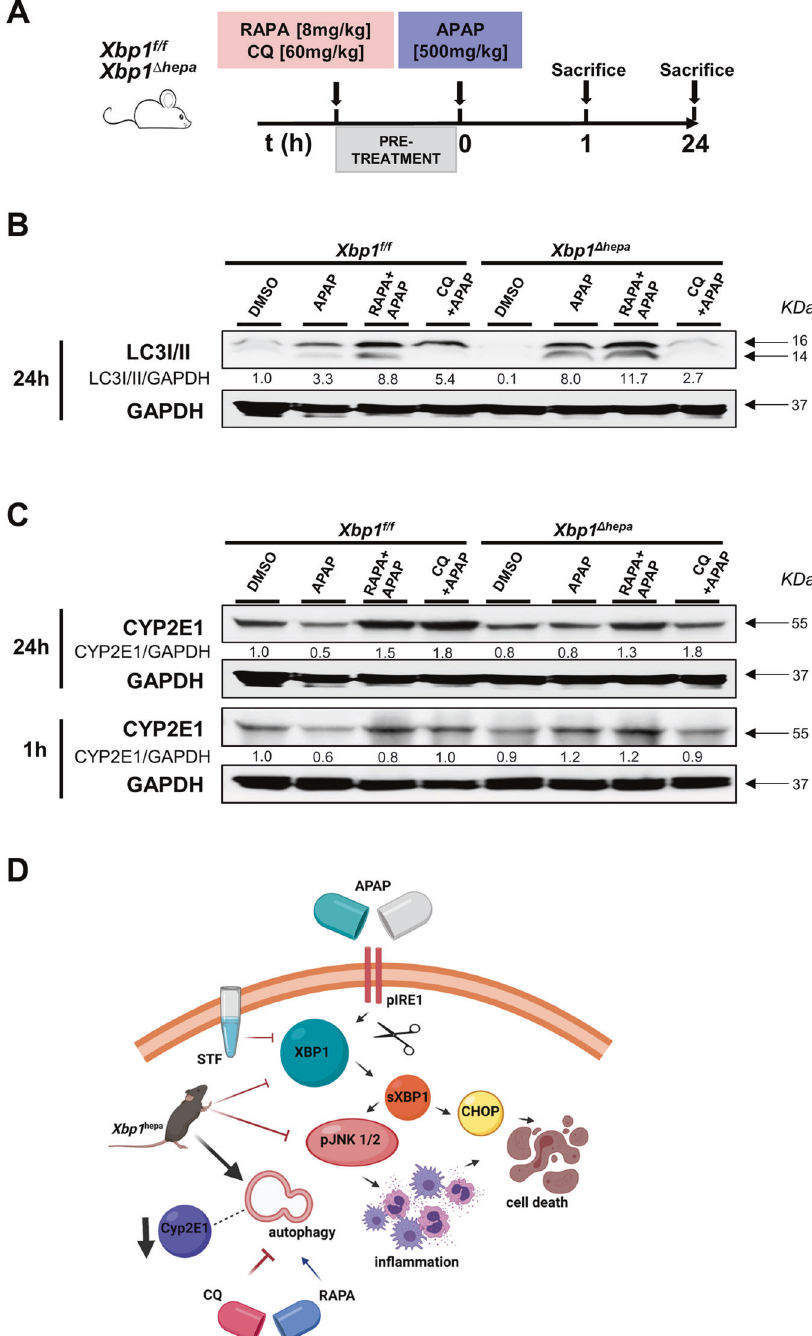
Fig. 7 Autophagy intervention using rapamycin (RAPA) or chloroquine (CQ) during early and late APAP-derived hyperacute liver injury. A Xbp1 f/f and Xbp1 Δ hepa mice were intraperitoneally injected with either rapamycin (RAPA) [8 mg/kg] or chloroquine ( CQ) [60 mg/kg], 1 h prior to APAP [500 mg/kg] challenge, and sacri fi ced at early (1 h) or late times (24 h) after APAP toxicity. B Protein levels of LC3I/II were determined in Xbp1 f/f and Xbp1 Δ hepa mice, pretreated with RAPA or CQ and sacri fi ced 24 h APAP challenge. C Protein levels of CYP2E1 were determined in Xbp1 f/f and Xbp1 Δ hepa mice, pretreated with RAPA or CQ and sacri fi ced 24 h (top panel) – same membrane used as in ( B ) and 1 h (bottom panel) post-APAP. GAPDH was used as a loading control. Relative protein levels were quanti fi ed using ImageJ software. D Schematic representation of the effects of genetic deletion of XBP1 in hepatocytes and pharmacological intervention, during APAP hepatotoxicity.